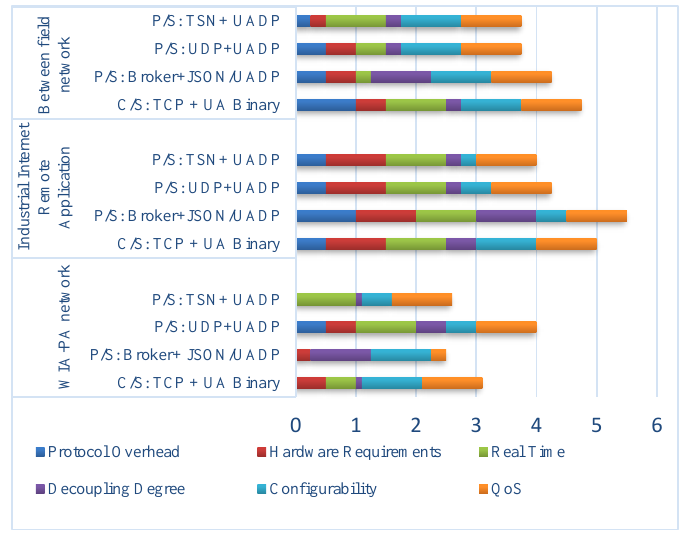
Figure 3. Feasibility analysis of OPC UA P/S applied to WIA-PA.